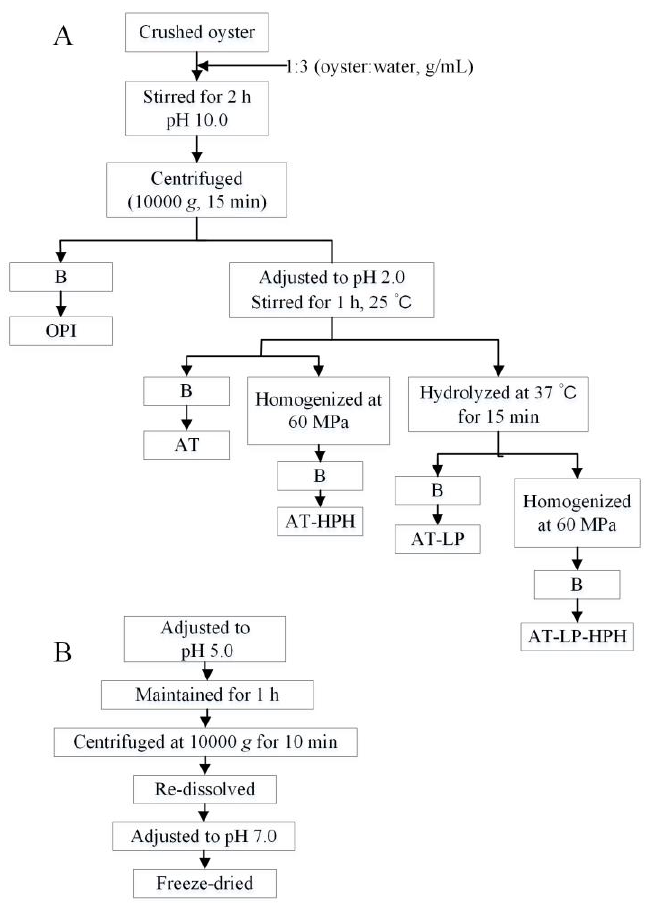
Figure 6. Scheme of sample preparation. Phase ( A ) and phase ( B ).